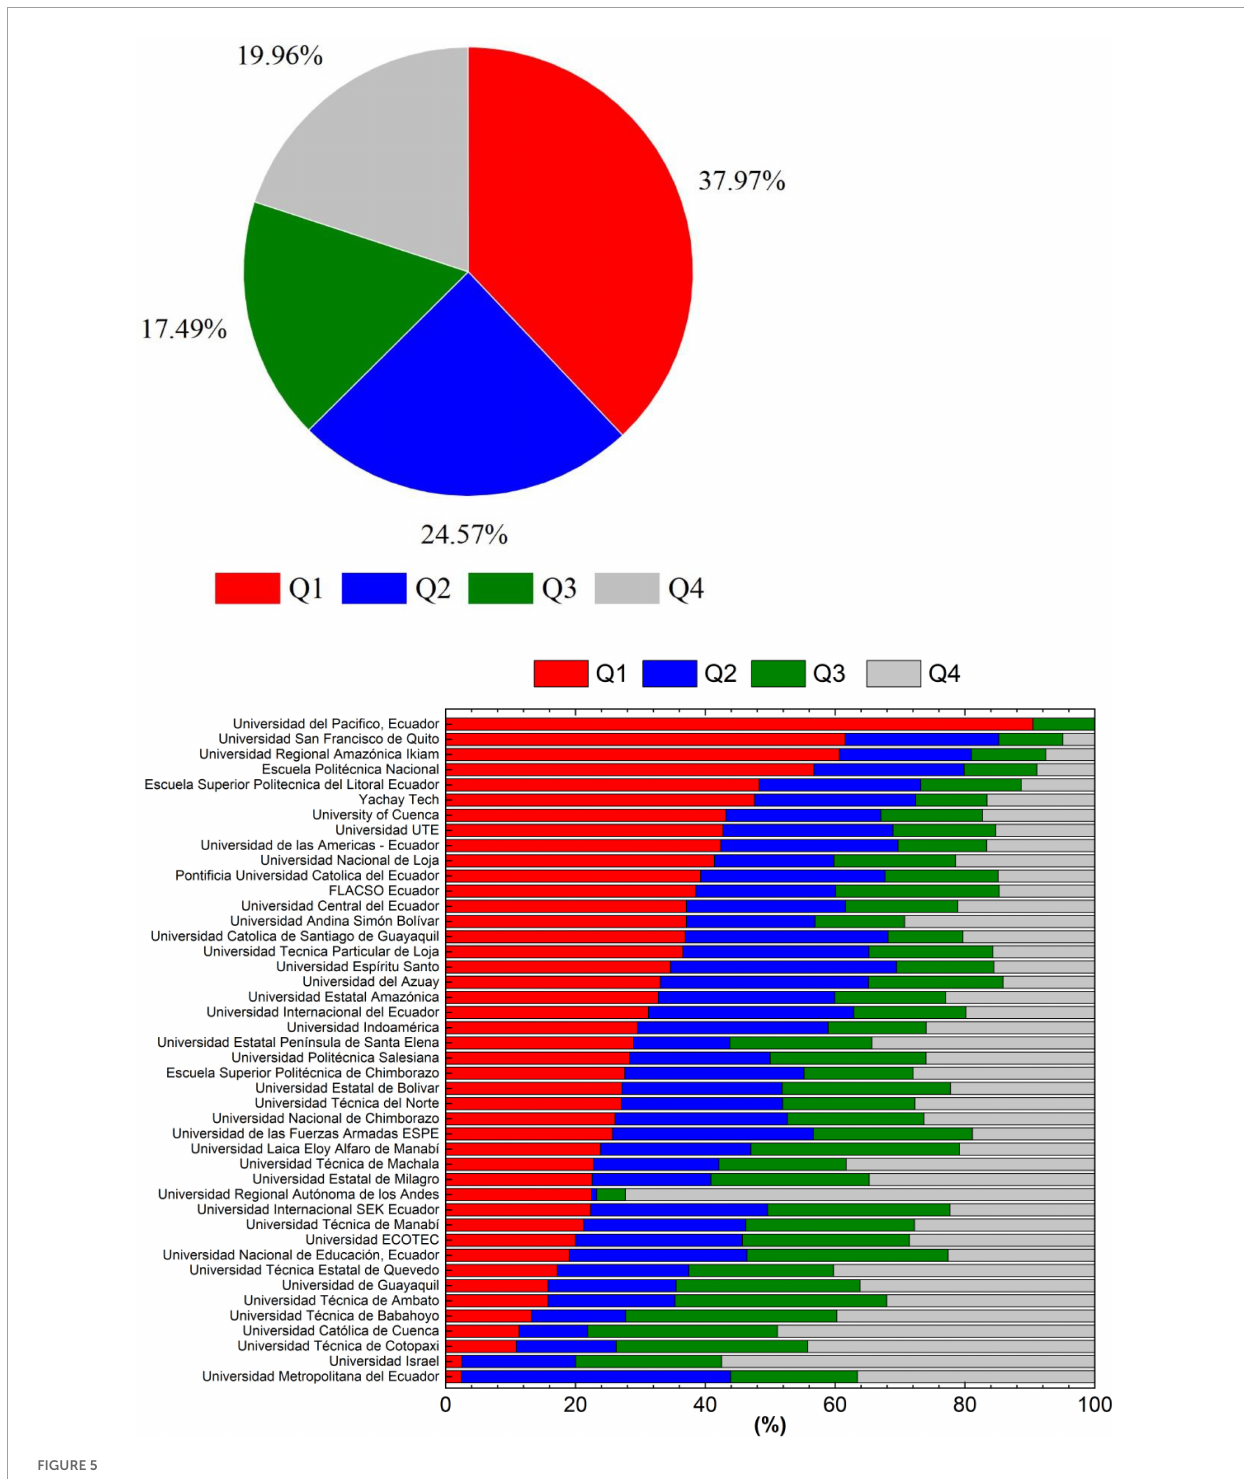
FIGURE5 Quartiles of the documents produced by all (Left) and each (Right) of the Ecuadorian Universities.